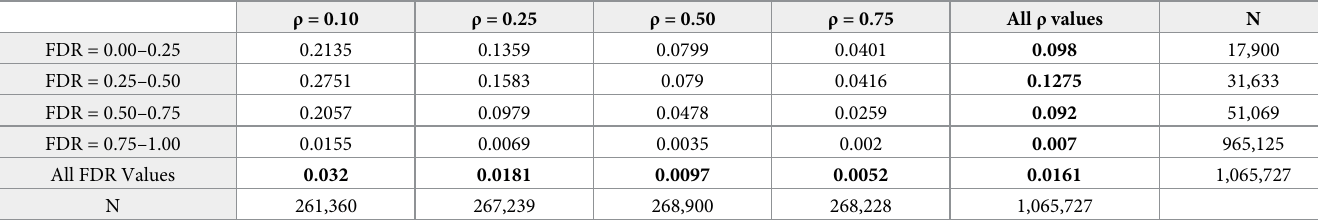
Table 3. Error of calculated false discovery rate for simulations with fixed sampling